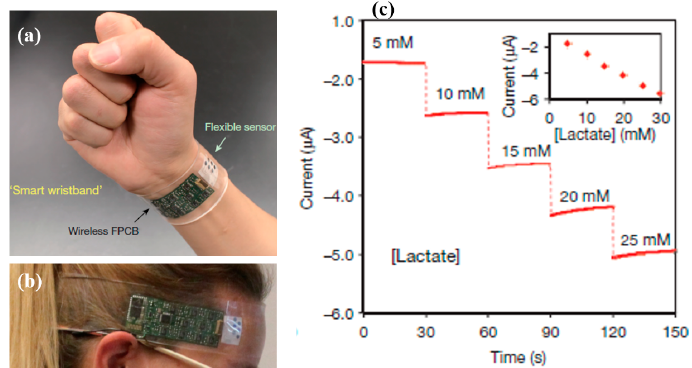
Figure 7. (a) Photograph of a wearable sensor array on a subject’s wrist; (b) smart headband; (c) chronoamperometric responses of lactate at different concentrations [61] ( reproduced with